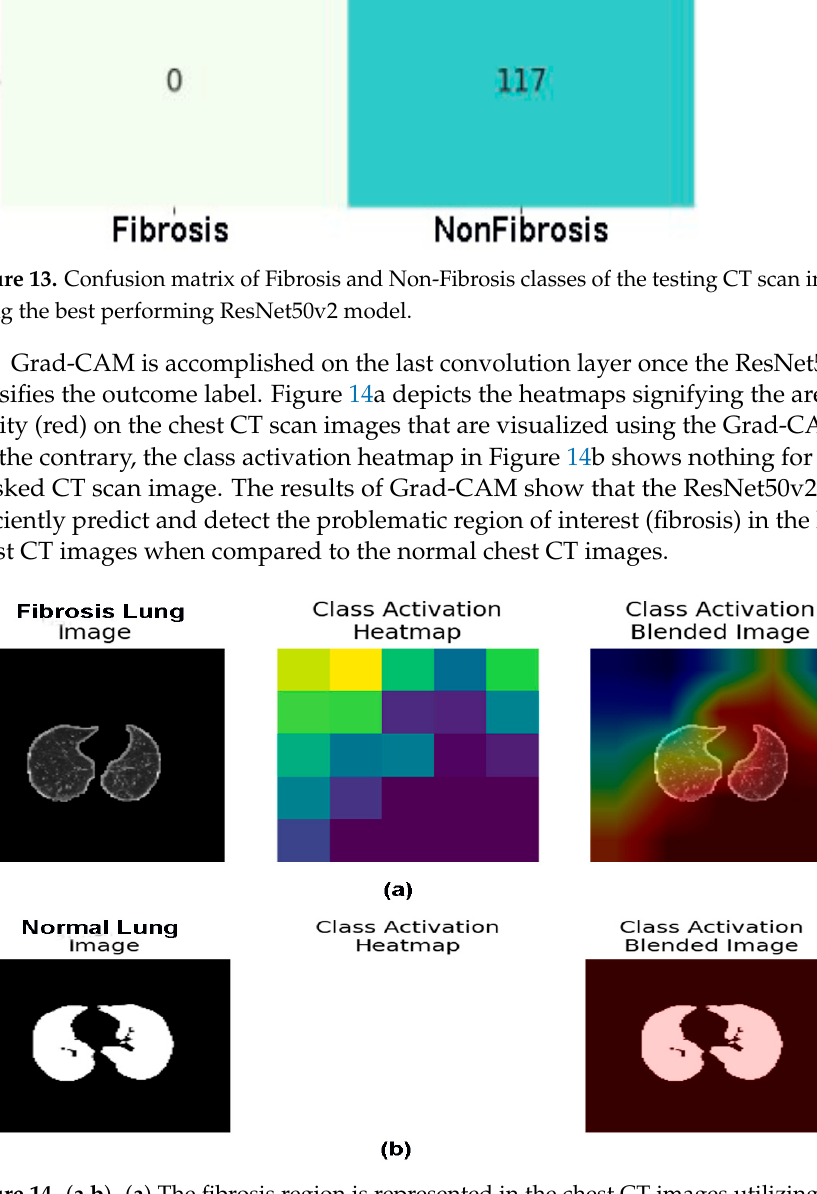
Figure 14. ( a , b ). ( a ) The fibrosis region is represented in the chest CT images utilizing Grad-CAM heatmap on the final layer of the ResNet50v2 model, and ( b ) Illustrate the normal chest CT image by applying Grad-CAM heatmap on the last layer of the ResNet50v2 model.